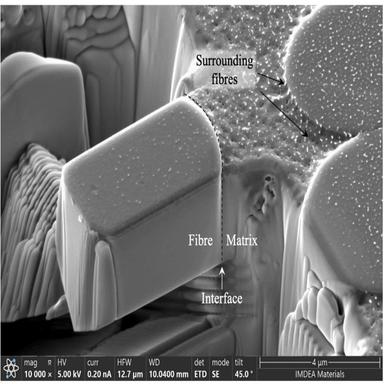
SEM image of a ready to be tested micro-cantilever beam.